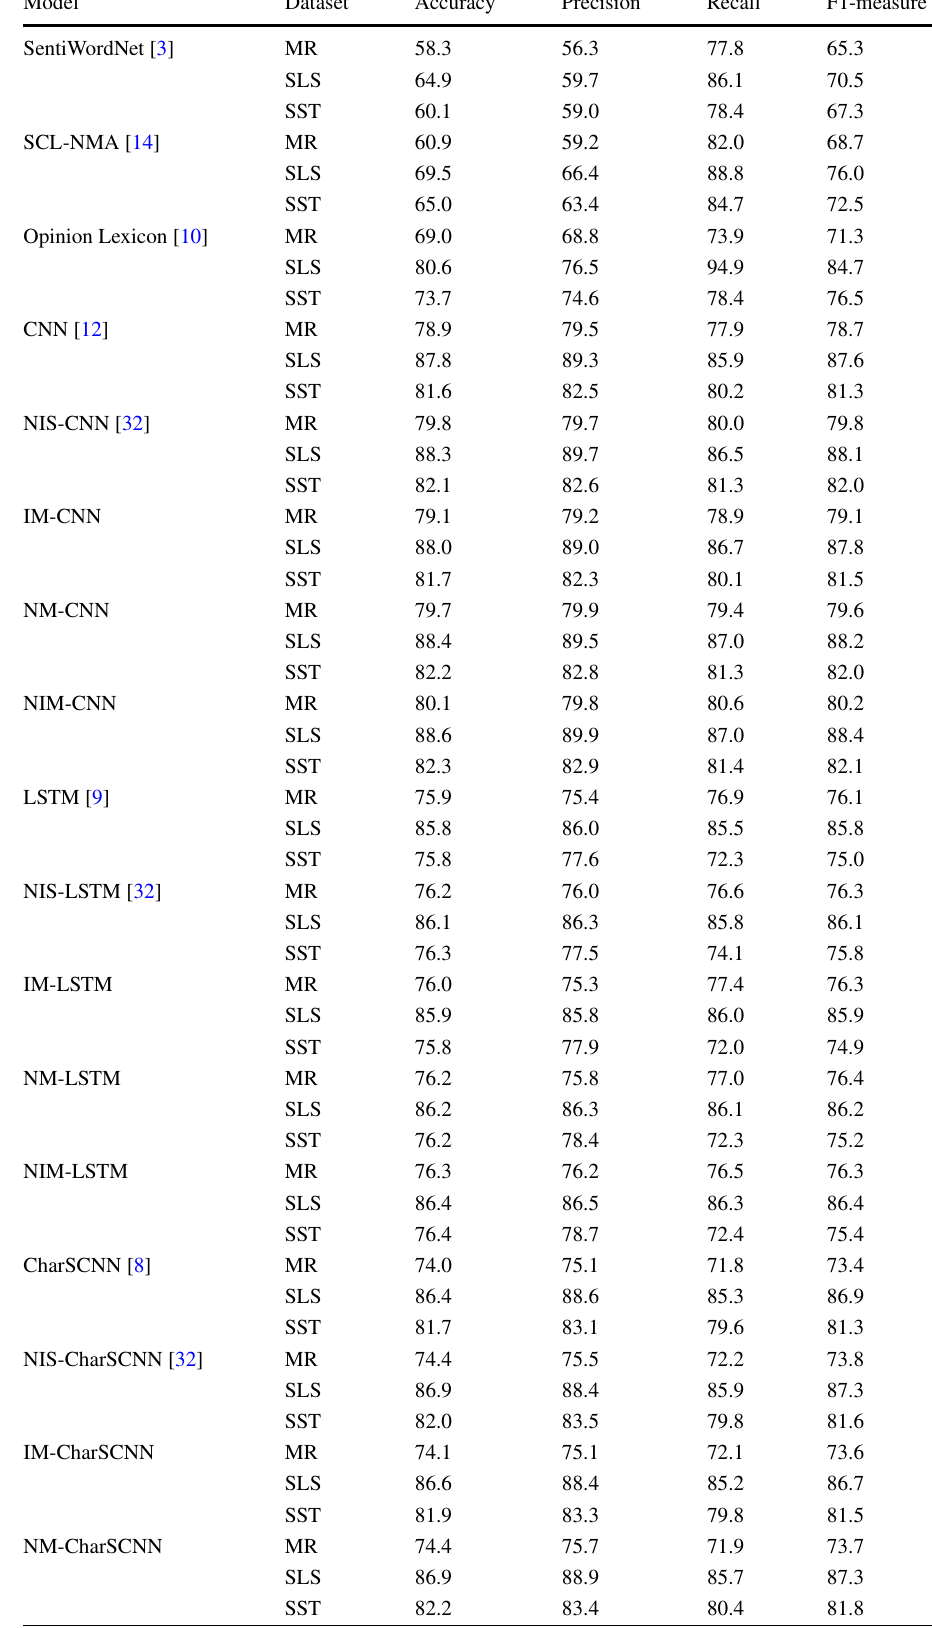
Table 5 Accuracy (%) of all models on MR, SST, and SLS